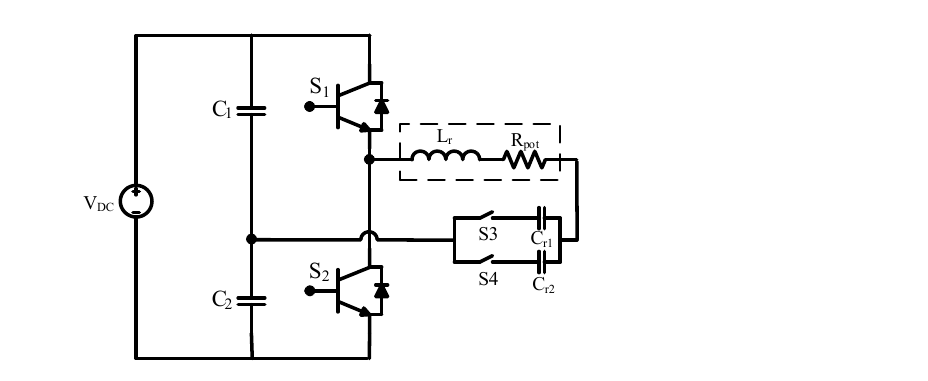
Figure 4. Proposed circuit diagram for ferrous and non-ferrous heating modes.